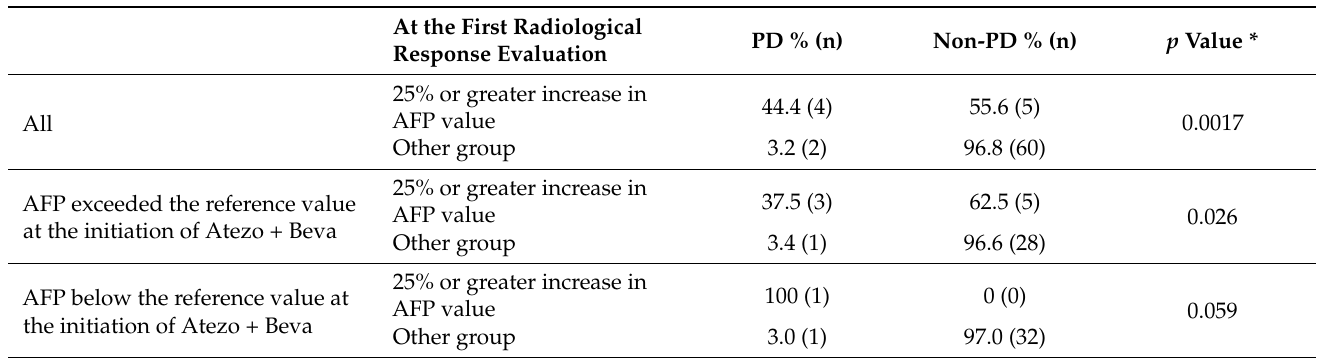
Table 4. Comparison of the rate of PD at the second radiological response evaluation in view of AFP exceeded or below the reference value (10 ng/mL) at the initiation of atezolizumab plus bevacizumab (Atezo + Beva) between the group with a 25% or greater increase in AFP values at the first radiological response evaluation from Atezo + Beva initiation and the other